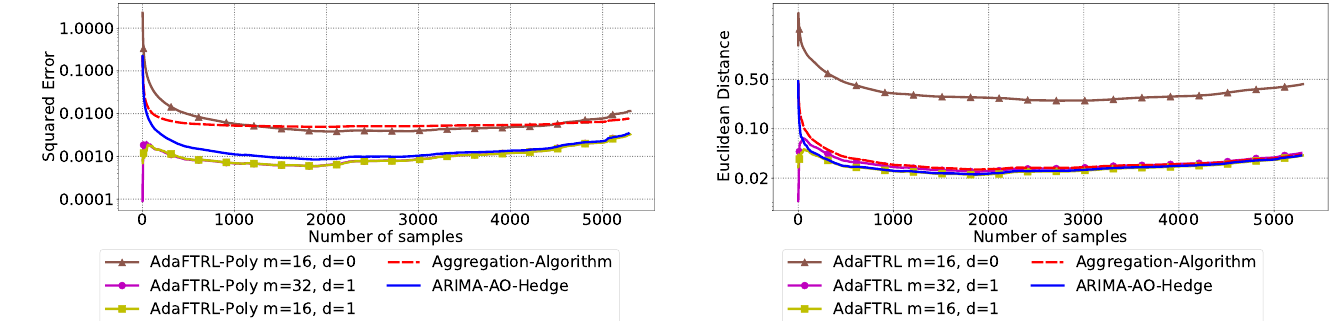
Figure 9. Model selection in setting 3.